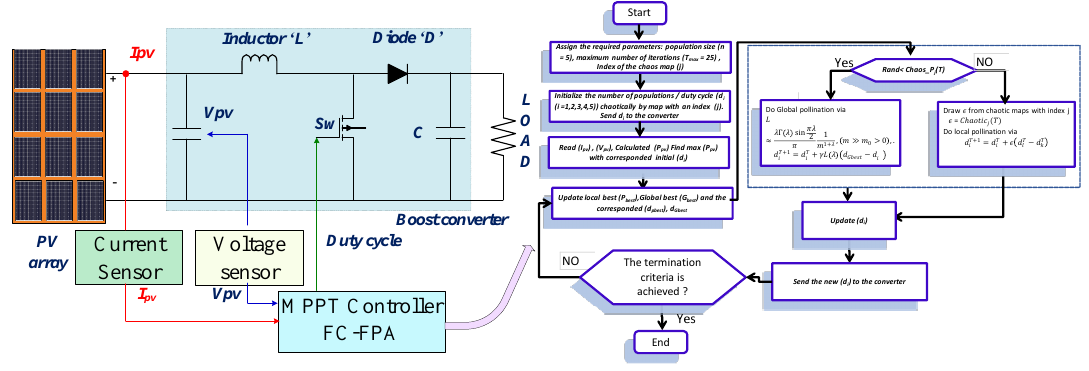
Figure 5. MPPT system design with the flowchart of